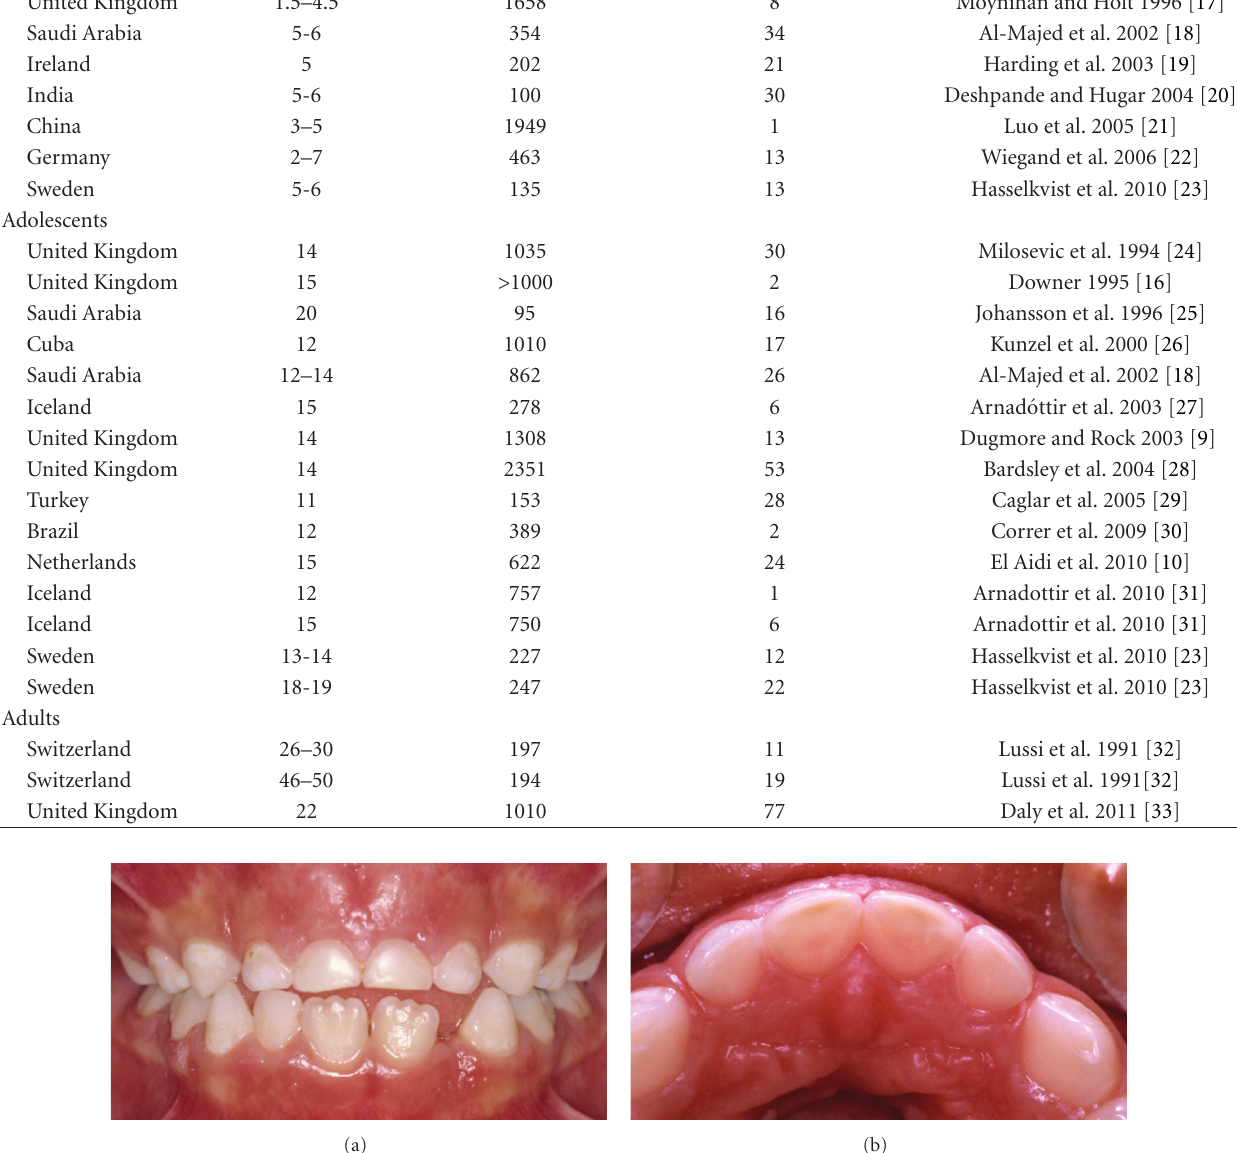
Figure 3: (a) A 6-year-old boy with dental erosion associated with a high intake of soft drinks and juice. Note the “melted” appearance of the buccal surfaces on teeth nos. 51–61. (b) Palatally on the maxillary front teeth the pulp is visible through the remaining tooth substance. Published with permission from the Swedish Dental Journal